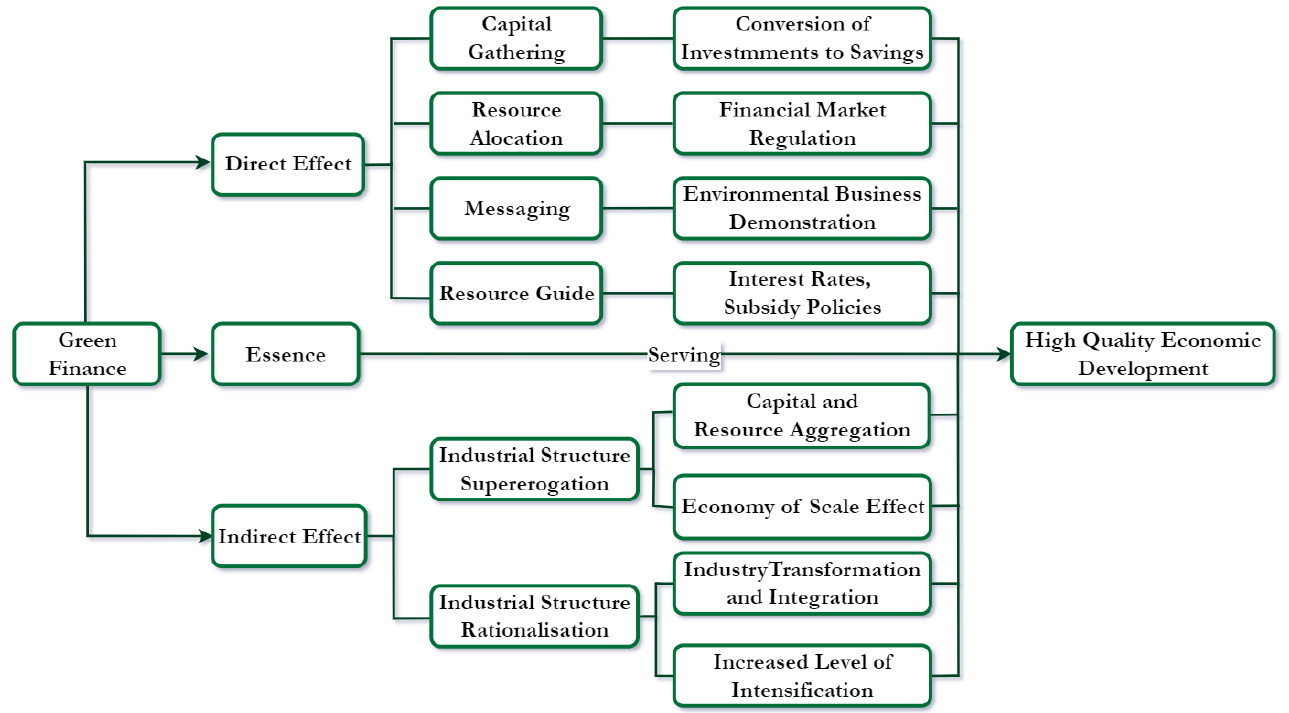
Figure 1. Mechanism of action of green finance and high-quality economic development.